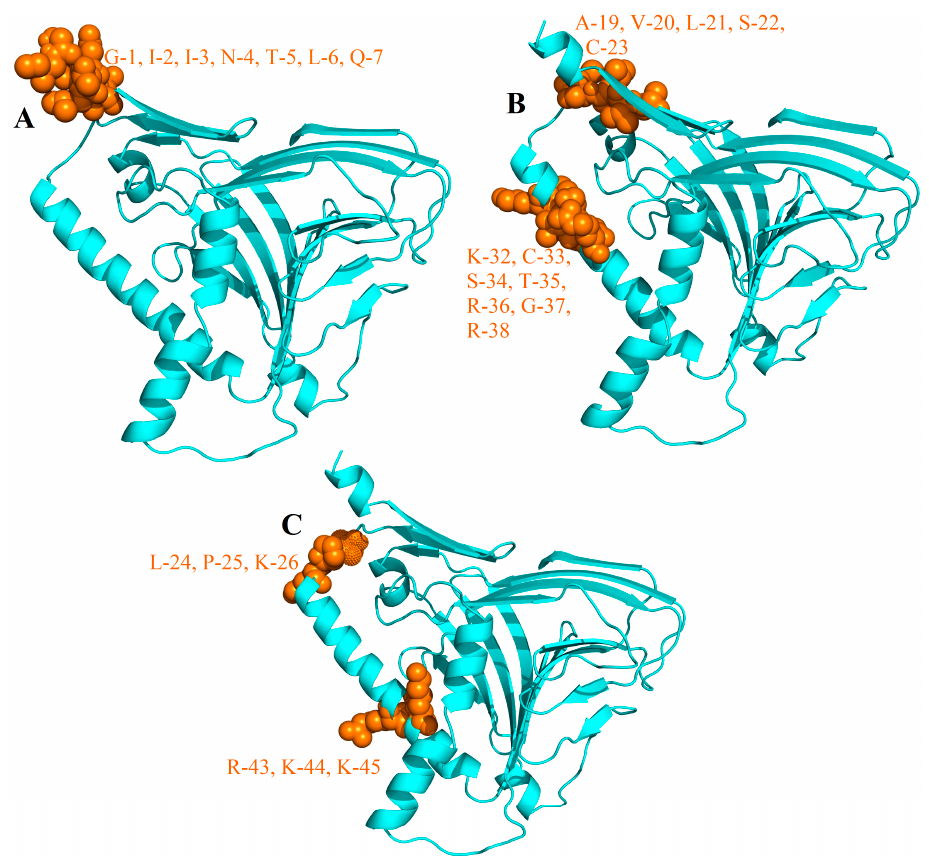
Figure 7. Conformational B-cell epitopes (brown) identified in the final MEV vaccine (cyan): ( A ) 7 residues (AA 1–7 ); ( B ) 12 residues (AA 19–23 , AA 32–38 ); ( C ) 6 residues (AA 24–26 , AA 43–45 ). Table 3. Linear B-cell epitopes in the final MEV vaccine construct.